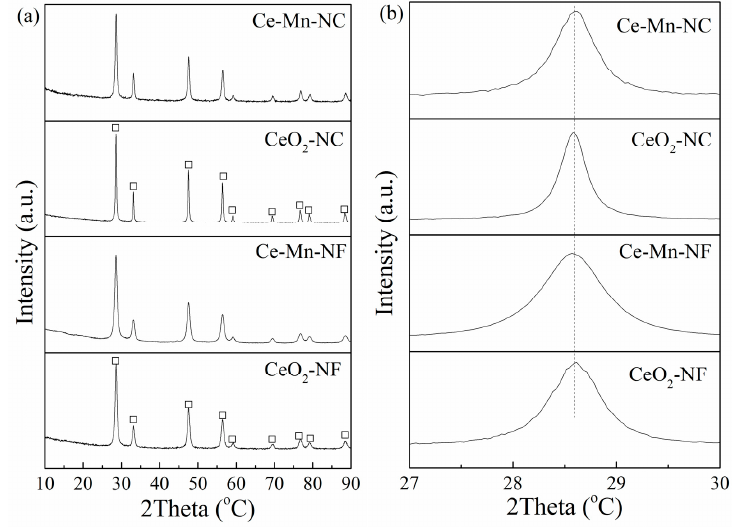
Figure 1. XRD patterns of CeO 2 -NF, CeO 2 -NC, Ce-Mn-NF and Ce-Mn-NC: ( a ) wild angle patterns, and ( b ) Enlarged-zone patterns. Table 1. Lattice parameters and extent of expansion of synthesized samples compared with those of pure CeO 2 .